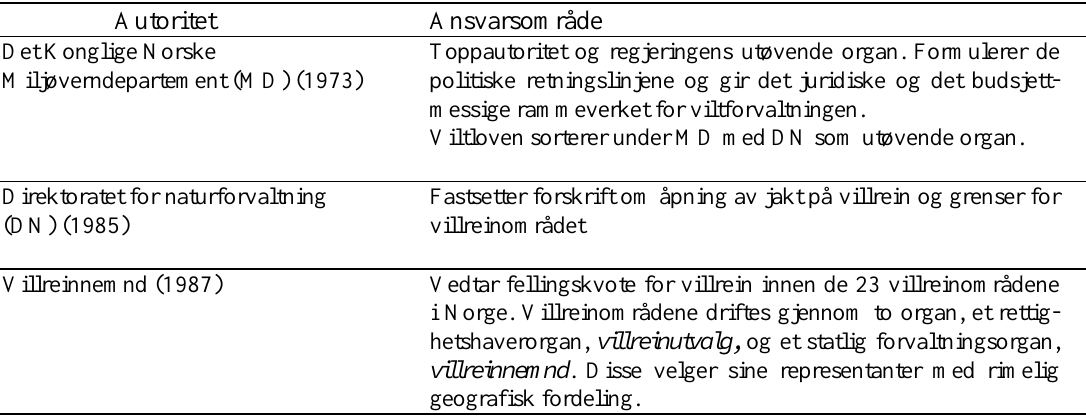
Tabell 1. De offentlige organene som har ansvar i villreinforvaltningen, og året de ble etablert. Autoritet Ansvarsområde Det Konglige